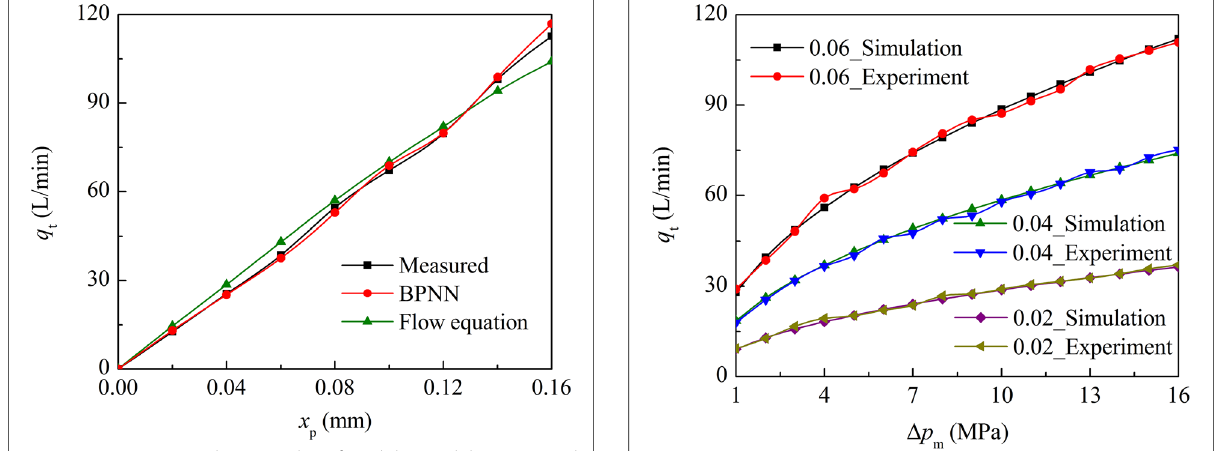
Figure 9 Comparisons between the inferred data and the computed data in case 1